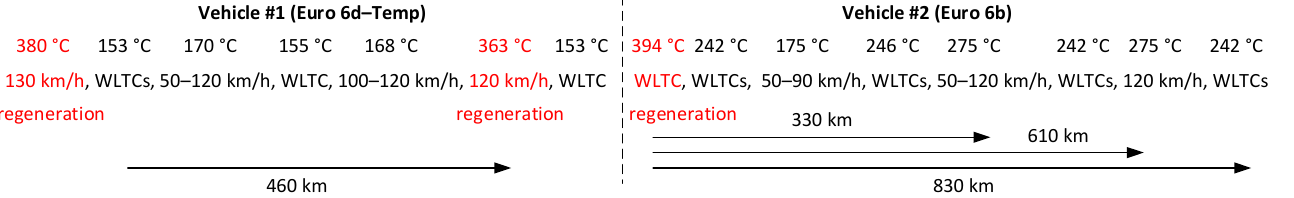
Figure 2. Schematic presentation of the test protocol. Temperatures are the maximum exhaust gas tailpipe temperatures of the specific tests. In red, tests where active regeneration took place. The 330 km and 610 km indicate the first and third test at 120 km/h which will be discussed in the Results section.